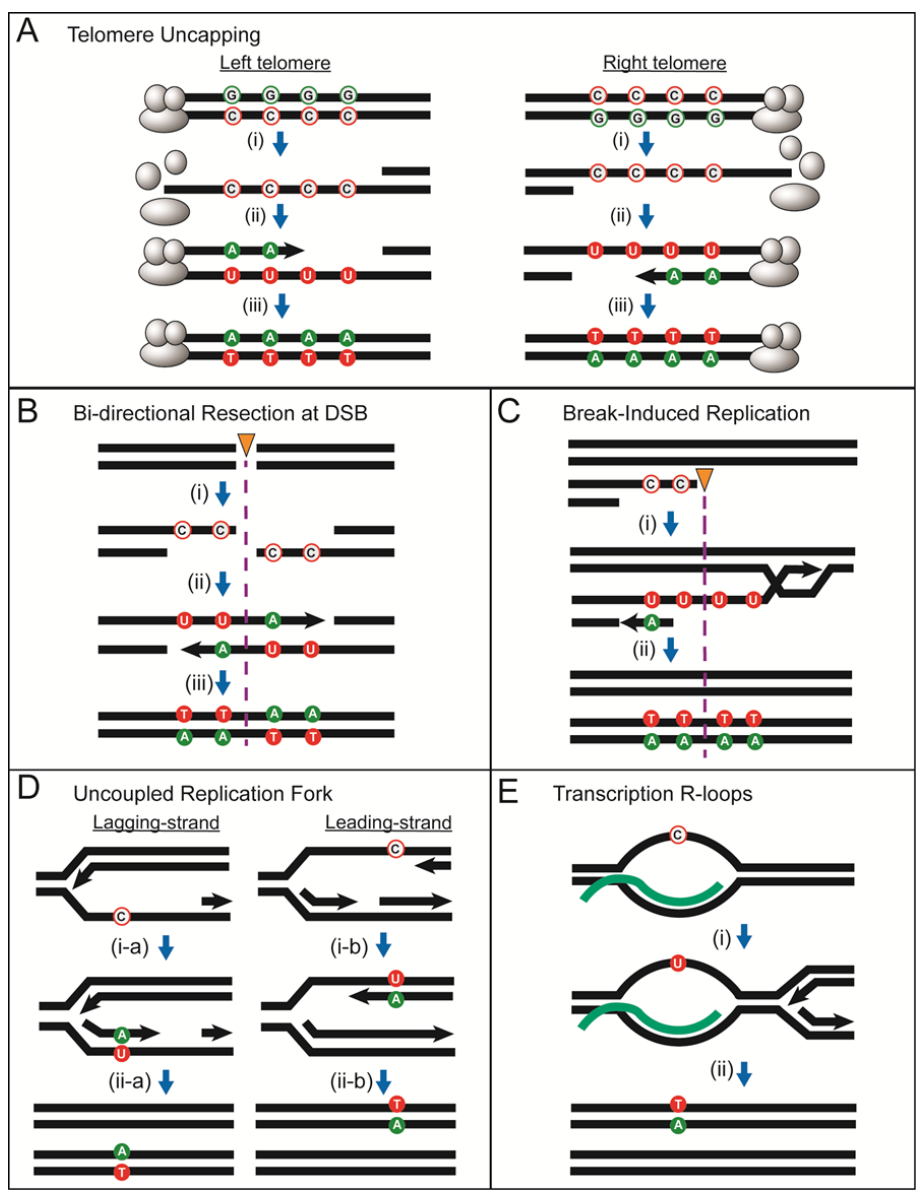
FIGURE 13: Cellular processes generating transient ssDNA vulnerable to hypermutation by APOBEC. The following symbols in the figure include: “unfilled green circl es” = non - mutated guanines; “unfilled red circles” = non - mutated cytosines; “green - filled circles” = mutated guanines; “red - filled circles” = muta t- ed cytosines; “black arrow heads” = 5’ to 3’ DNA synthesis; “orange triangle with purple dotted line” = posit ion of double- strand break; “C” = cytosine; “A” = adenine; “U” = uracil; “T” = thymine. In all models, C to U changes are due to APOBEC cytosine deamination. (A) Long ssDNA generated at uncapped telo- meres. (i) telomere uncapping triggers 5’ to 3’ end rese ction and G2 cell cycle arrest, generating long stretches of persistent ssDNA that provides a substrate for deamination of cytosines to uracils by APOBEC. (ii) the capping of telomeres is reestablished, initiating restoration of dsDNA with adenines inserted in the nascent DNA opposite the uracils. (iii) after the next round of replication, mutations are fixed, resulting in C:G to T:A transitions. Deamination of cytosines in the left telomeres result in G-coordinated clustered mutations on the top strand, while deamination of cytosines in the right telomeres result in C- coordinated clustered mutations on the top strand. (B) ssDNA formed from bi-directional resection at a double- strand break (DSB). (i) 5’ to 3’ end rese ction on both sides of a double strand break result in ssDNA in the top strand on the left-side of break and in ssDNA in the bottom strand on the right-side of the break. Cytosines in ssDNA on both sides of the break will be deaminated by APOBEC. (ii) and (iii) restoration of dsDNA using a sister chromatid or a homolo- gous chromosome template followed by a round of replication will generate a single switch in strand coordination from C to G in a 5’ → 3’ direction of the top strand. (C) ssDNA formed from the repair of a one-ended DNA break via BIR. (i ) 5’ to 3’ end resection results in a 3’ overhang that invades a homologous template and initiates DNA synthesis that progresses via a migrating replication bubble that generates a long ssDNA tail behind the bubble. Asynchronous lagging strand synthesis initiates to restore DNA to double strand form resulting in C-coordinated clustered mutations. If BIR initiated repair from the oppo- site side of a break such that ssDNA was generated on the bottom strand, then this would result in a G-coordinated cluster. (D) Long ssDNA could form from uncoupling between replicating leading and lagging strands. (i-a) and (ii-a) stalling of lagging strand synthesis resulting in ssDNA formed on the bottom strand leading to a mutated guanine. (i-b) and (ii-b) stalling of leading strand synthesis resulting in ssDNA formed in the top strand leading to a mutated cytosine. If uncoupling leads to long stretches of ssDNA, coordinated cluster formation is possible. In both cases, the origin of replication (not shown) is on the left side. The polarity of mutated cytosines or guanines depends on the fork direction. (E) Small stretches of ssDNA in the non-transcribed strand at transcription R- loops. (i) and (ii) ssDNA in the non-transcribed strand results in genome-wide bias towards APOBEC-mutated cytosines in non-transcribed strands. If uncou- pling leads to long stretches of ssDNA, coordinated cluster formation is